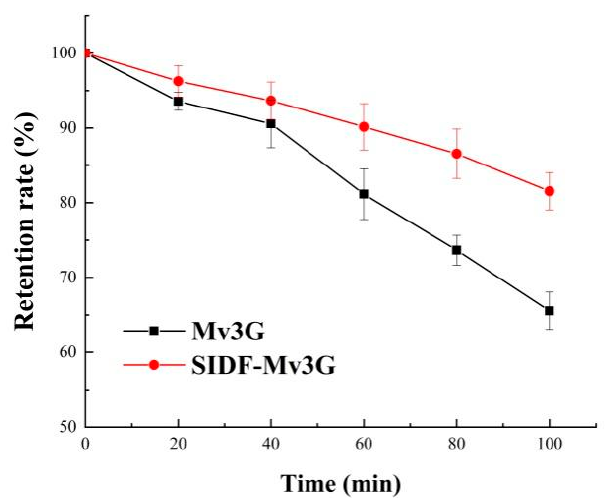
Figure 2. Retention rate of heat treatment at 100 °C for 100 min. SIDF-Mv3G: the stability system solution of soybean insoluble dietary fiber and malvidin-3- O -glucoside; Mv3G: malvidin-3- O -glucoside solution.